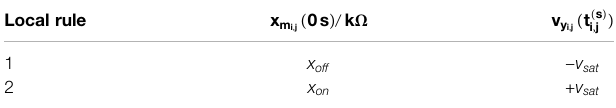
TABLE 6 | Set of local rules, which are imposed on the processing element C ( i , j ) of a M × N M-CNN, so as to allow the reading of the memory content, initially stored in the memristor M x , and its transfer to the steady-state output voltage i , j